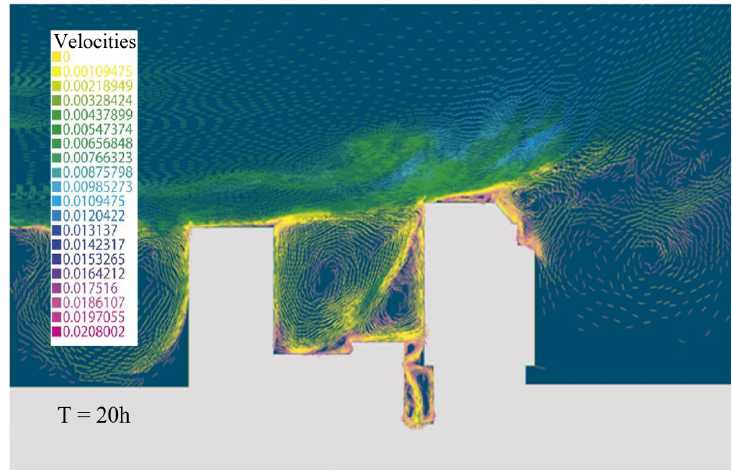
Figure 19. Test 2. Air velocities. Forced extraction and wind. Solar radiation is imposed as boundary conditions. Velocities: m/s. T: hours.